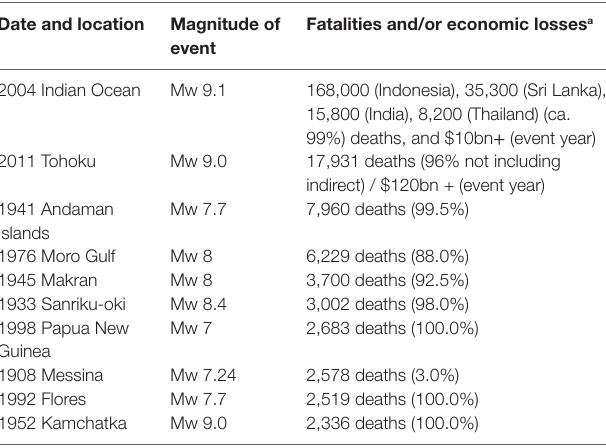
Table 4 | The effect of larger tsunami events since